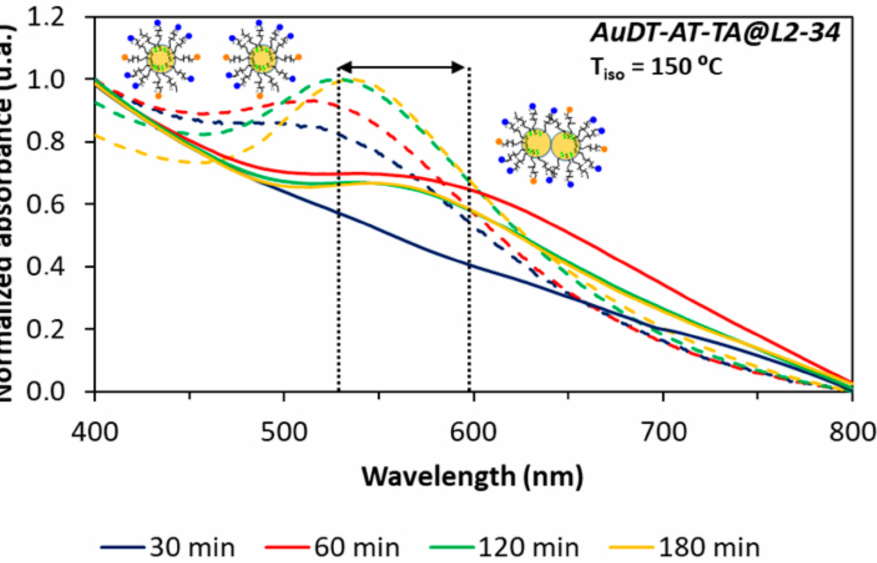
Figure 6. UV-vis spectra of AuDT-AT-TA@L2-3,4 NP’s in DCM solution (dashed line) and solid state (continuous line) after the isothermal